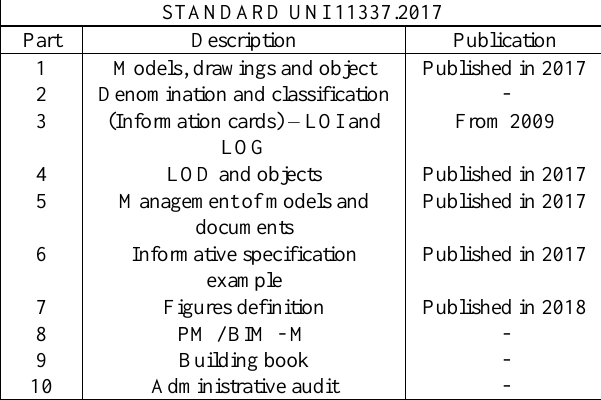
Table 1. The main contents of the UNI 11337-1:2017 standard